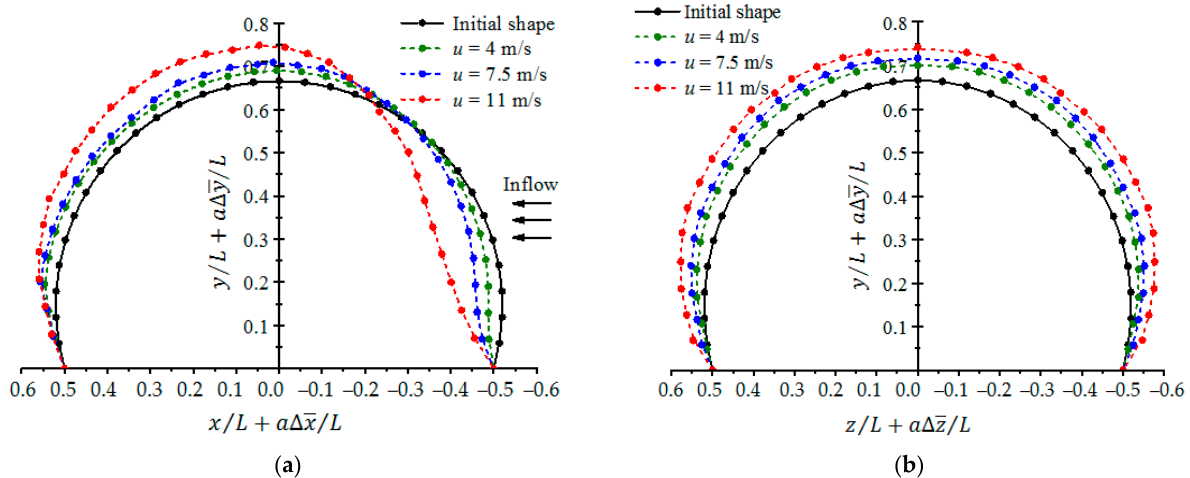
Figure 12. Average deformation profile of the model: ( a ) average deformation profile in xy plane and ( b ) average deformation profile in yz plane.